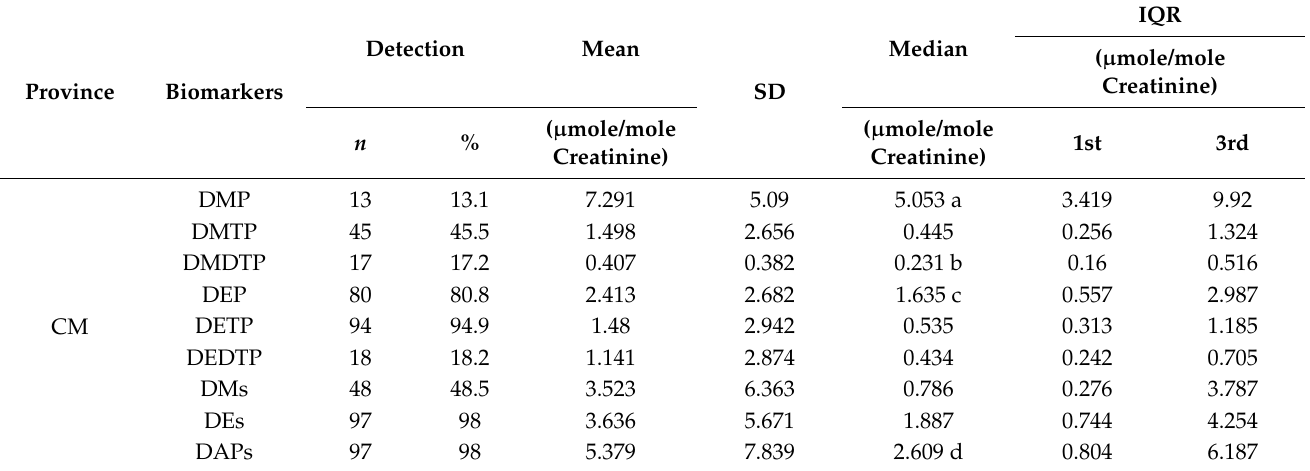
Table 4. DAPs detection frequency and concentration by